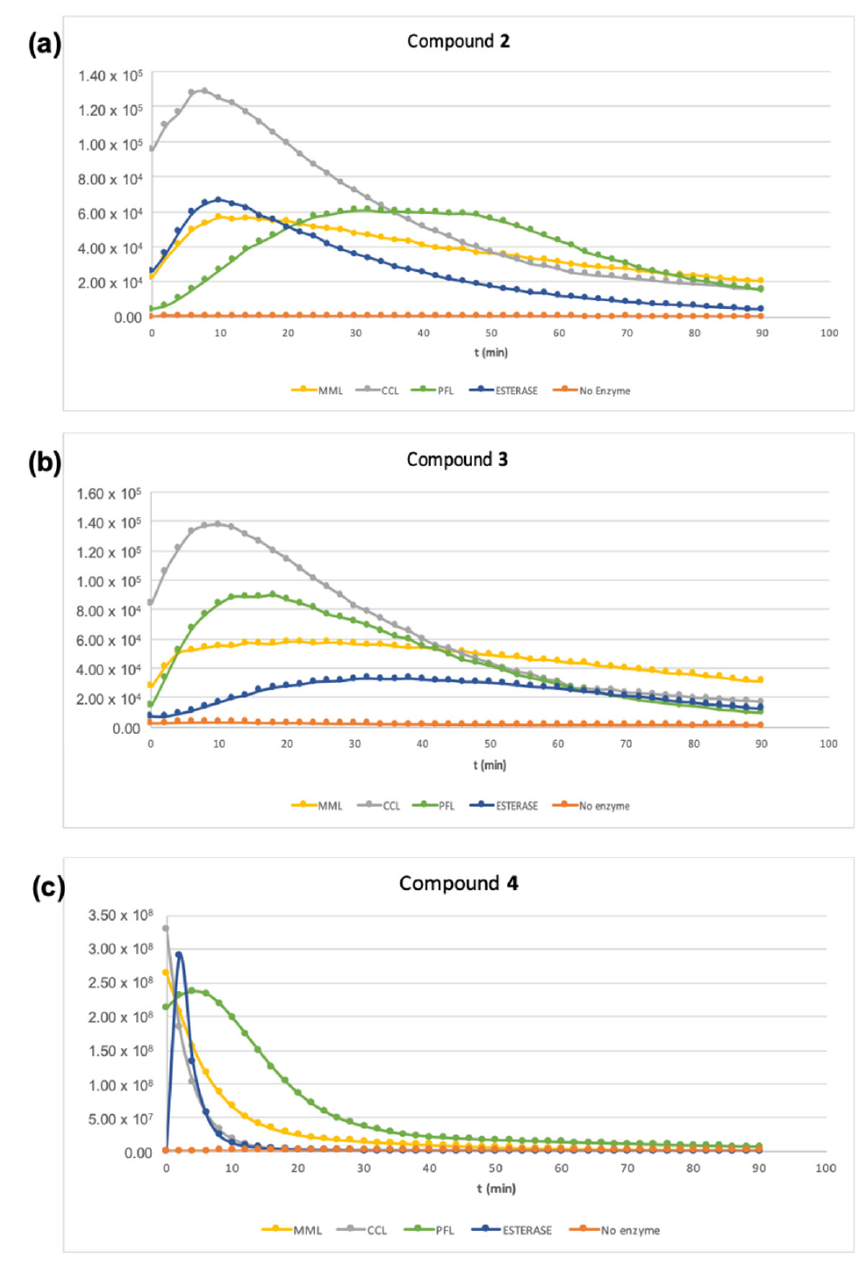
Figure 2. Chemiluminescence profile of compounds (final well concentration 10 µ M): ( a ) 2 , ( b ) 3 , and ( c ) 4 in Tris-HCl (pH 7.4, 1mM EDTA, 10% DMSO) in the presence or absence (no enzyme) of CCL, PFL, MML, and PLE (0.2 U/well for each enzyme) at room temperature. The chemiluminescent signal obtained from the lipase-catalyzed dioxetane